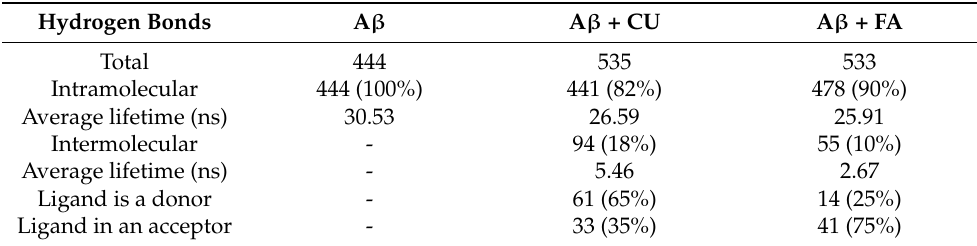
Table 2. Number, percentage and lifetime of intramolecular and intermolecular hydrogen bonds, calculated over 1000 ns.